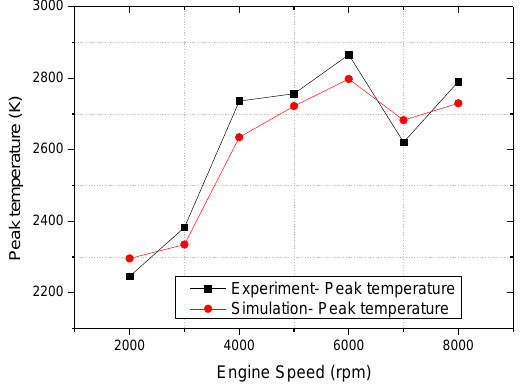
Figure 5. Air mass flow following engine speed.